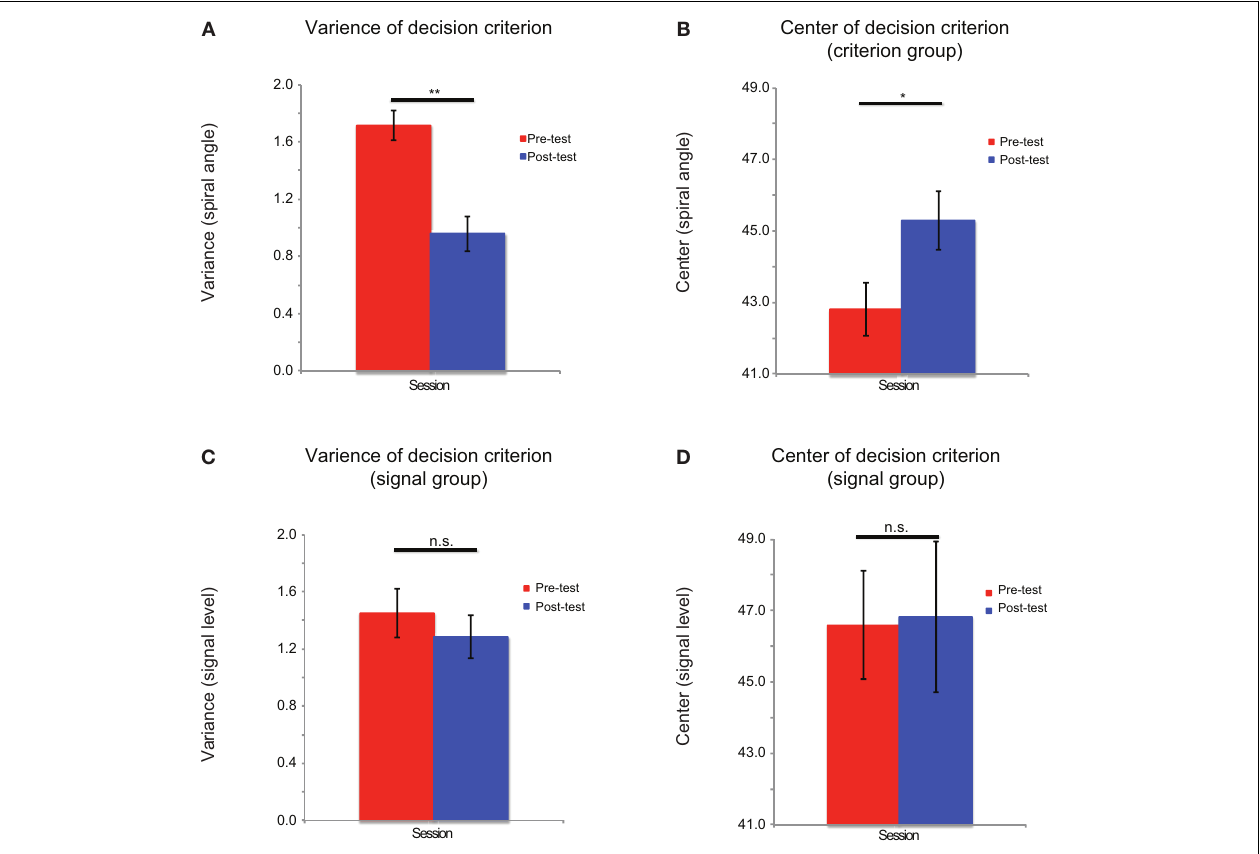
FIGURE 6 | Model fitting results for the criterion uncertainty. The criterion uncertainty is indexed by the variance of decision criterion. The fitting results are shown for (A) the variance of the decision criterion distribution of criterion comparison group, (B) the mean of the decision criterion of the